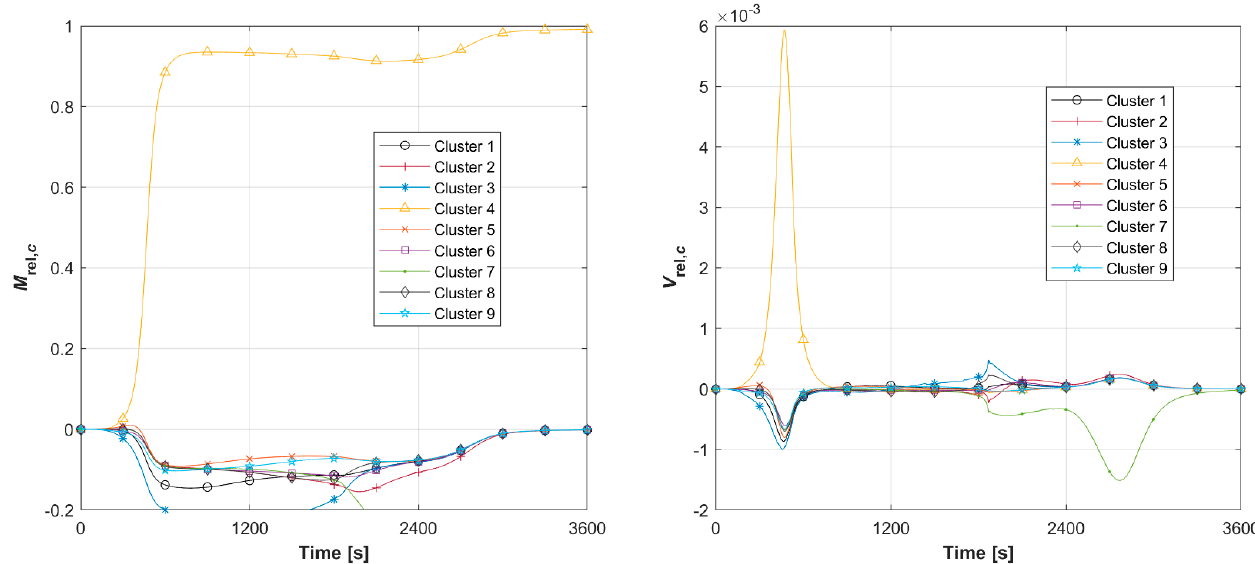
Figure 14. M rel , l , cj ( left ) and V rel , l , cj ( right ) trends for the scenario “partial closure of BV at 0 s, CP speed at 75% at 1 s, complete closure of CV2 at 71 s and complete closure of CV1 at 72 s.